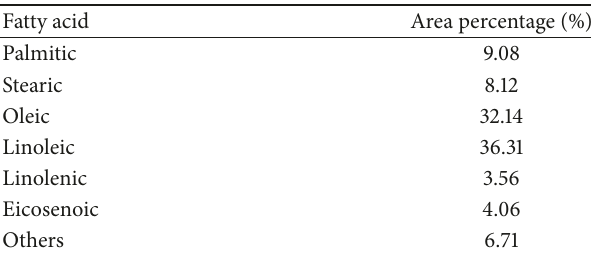
Table 1: Composition of fatty acids used as crosslinking agent. Characterization was made using a gas chromatography system (Agilent Technologies 6890 series), coupled to a FID detector, using an Agilent DB23 column and SUPELCO 38 FAMES as standards.